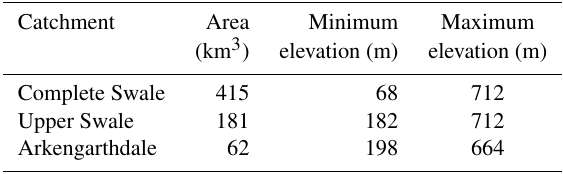
Table 1. Basin areas and elevations for the three test basins used.